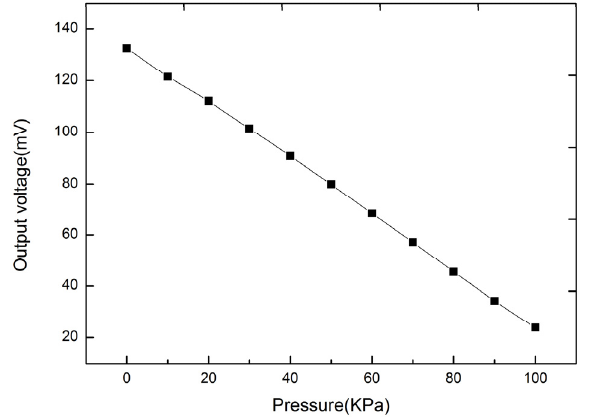
Figure 6. The force-sensitive characteristic of InAs QD-HEMT.